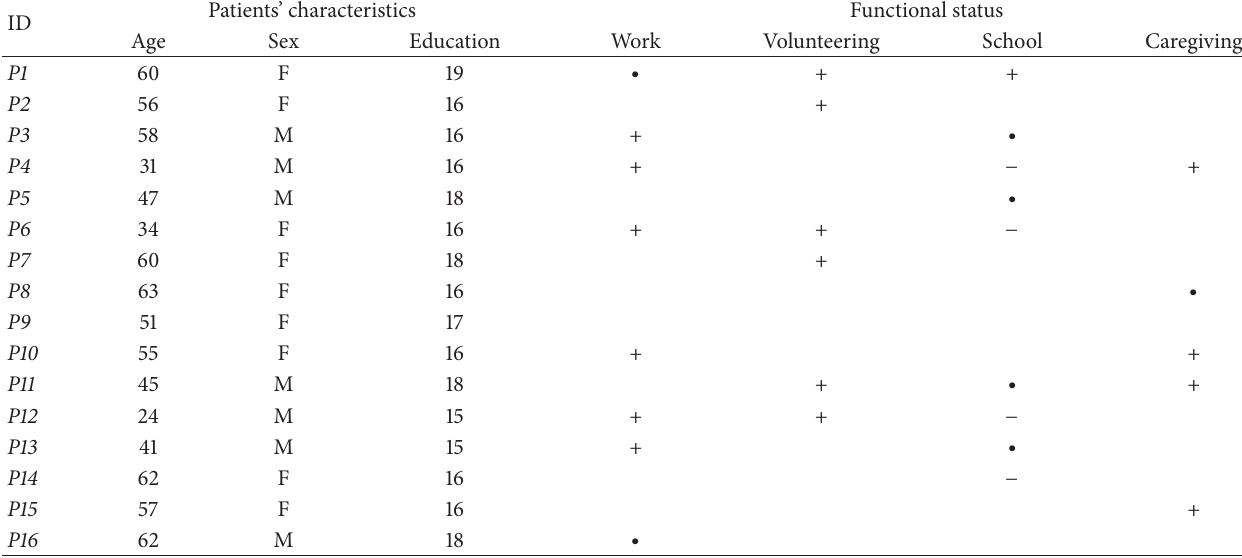
Table 1: Changes to functional status across life domains from baseline to follow-up.